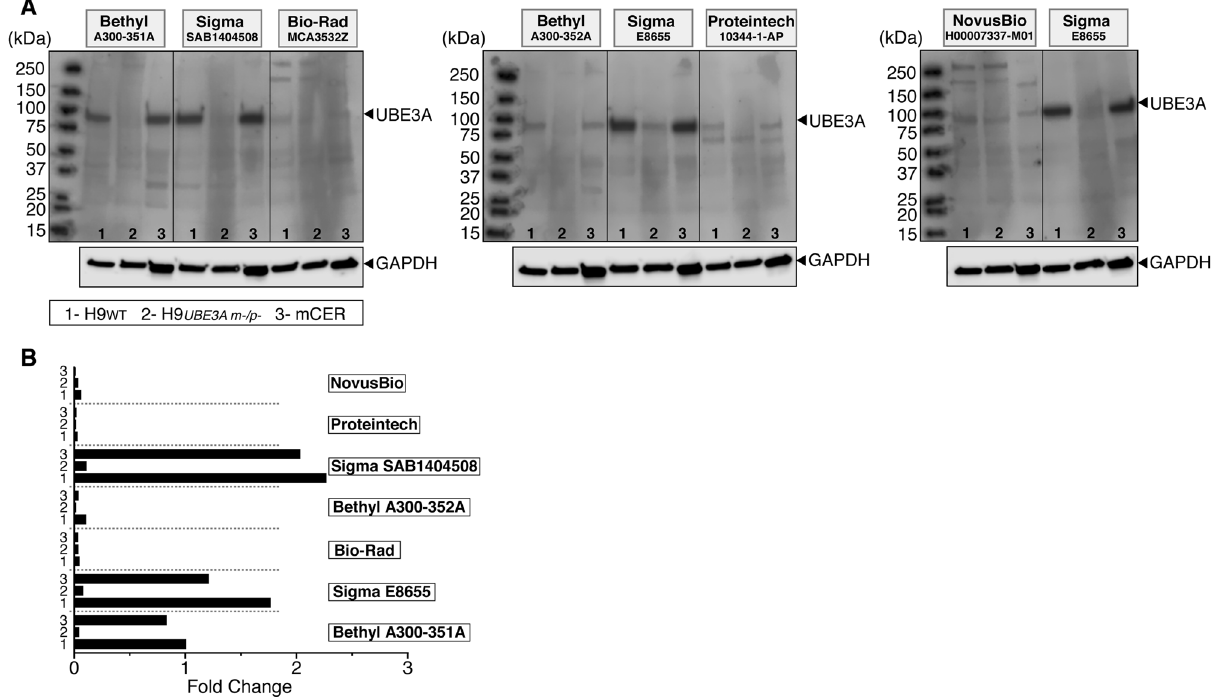
Figure 4. Four commercial antibodies show specific labeling of UBE3A in western blots. ( A ) Immunoblot analysis of UBE3A in whole cell lysates from H9 wild type (H9 WT ) hESCs, H9 double UBE3A knockout (H9 UBE3A m−/p− ) hESCs and wild-type mouse cerebellum (mCER) using seven different UBE3A antibodies. Full gels are depicted; vertical lines are drawn only for clarity. ( B ) Quantitative analysis of the UBE3A bands, normalized to